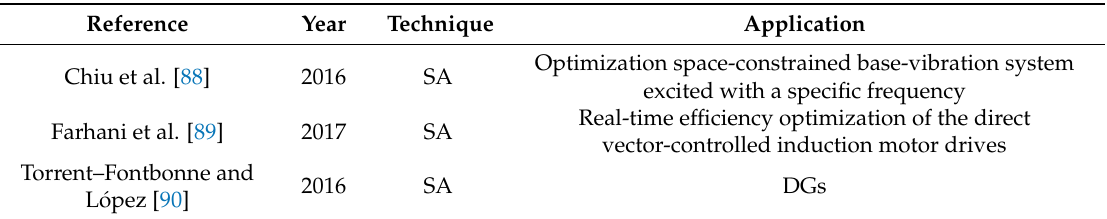
Table 8. Simulated annealing.